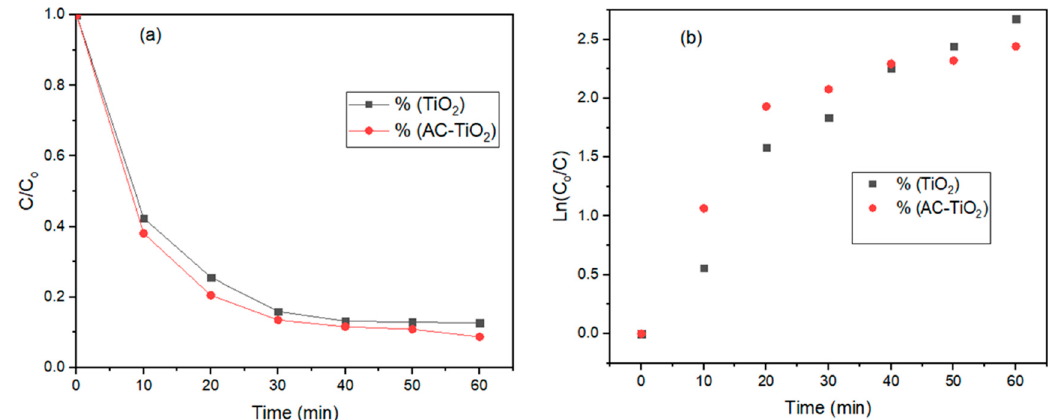
Figure 3. Comparative effect of TiO 2 (black) and AC-TiO 2 (red) on ( a ) decomposition of COD and ( b ) First-order kinetic model.